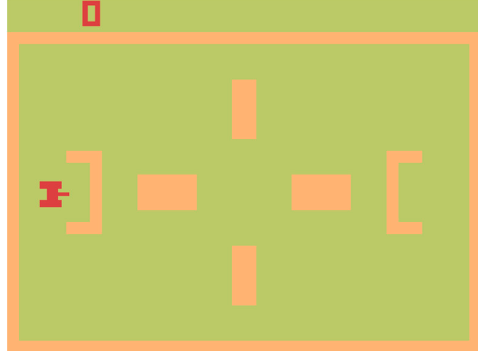
Figure 9. The player is alone in the world of Tokyo Story , with no family to turn to and likewise no enemy to pursue.